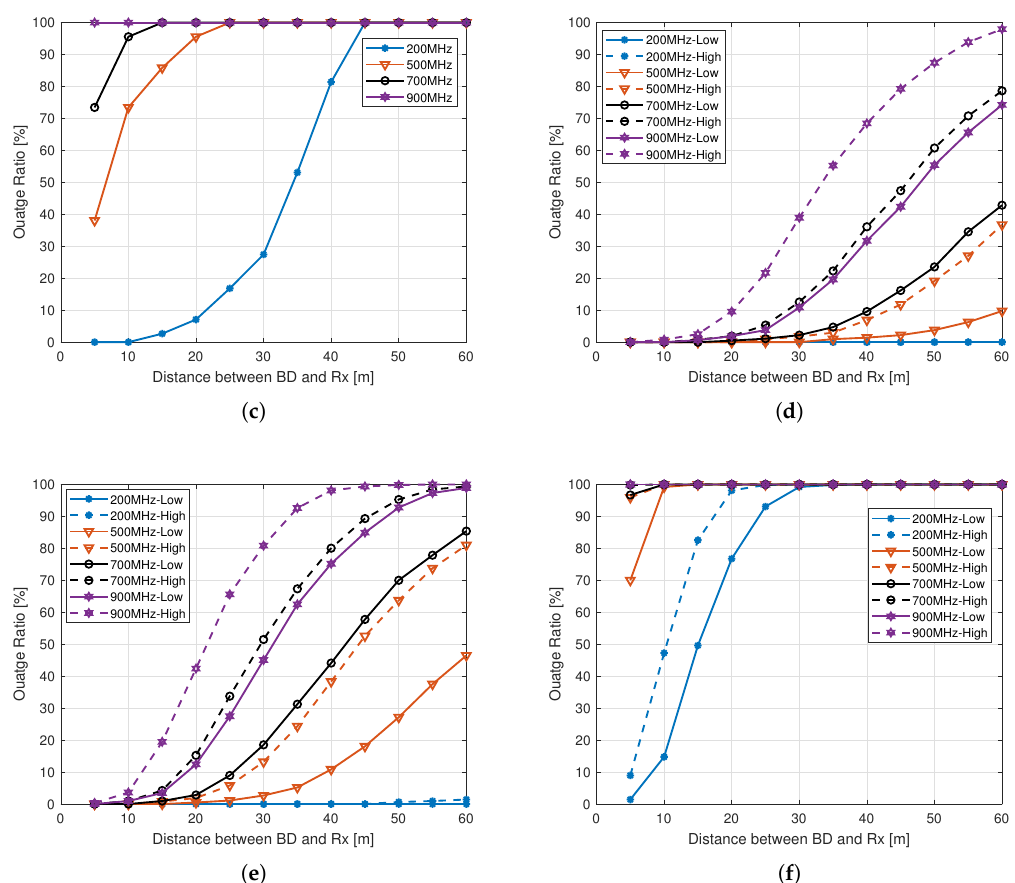
Figure 9. Outage ratio, ( a ) Outdoor LoRa, ( b ) Outdoor NB-IoT, ( c ) Outdoor BLE5, ( d ) Indoor LoRa, ( e ) Indoor NB-IoT, and ( f ) Indoor